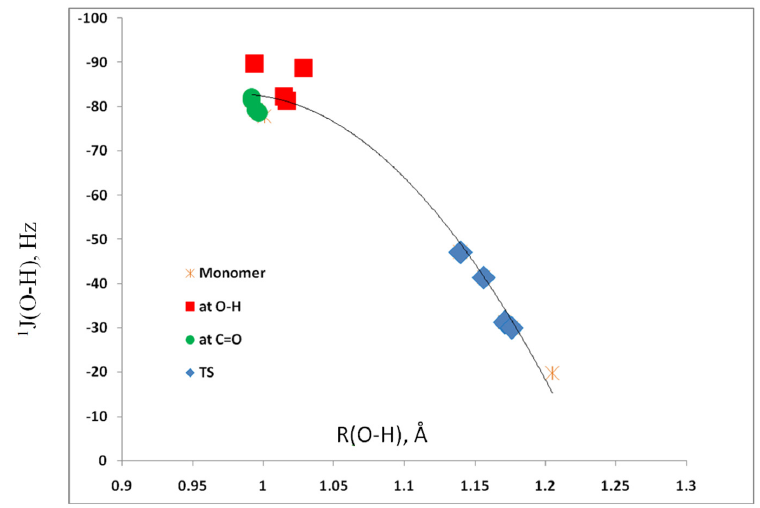
Figure 8. 1 J(O–H) versus the O–H distance for complexes 1 :acid.